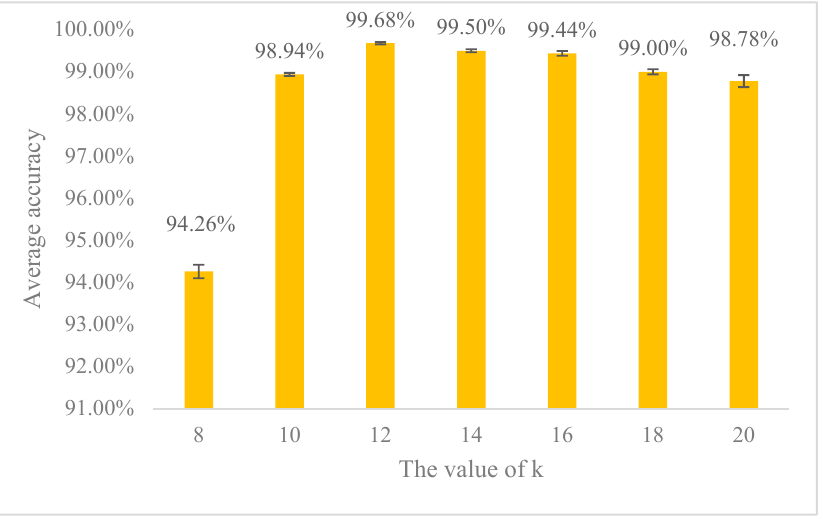
Figure 7. Accuracy and standard deviation of di ff erent k